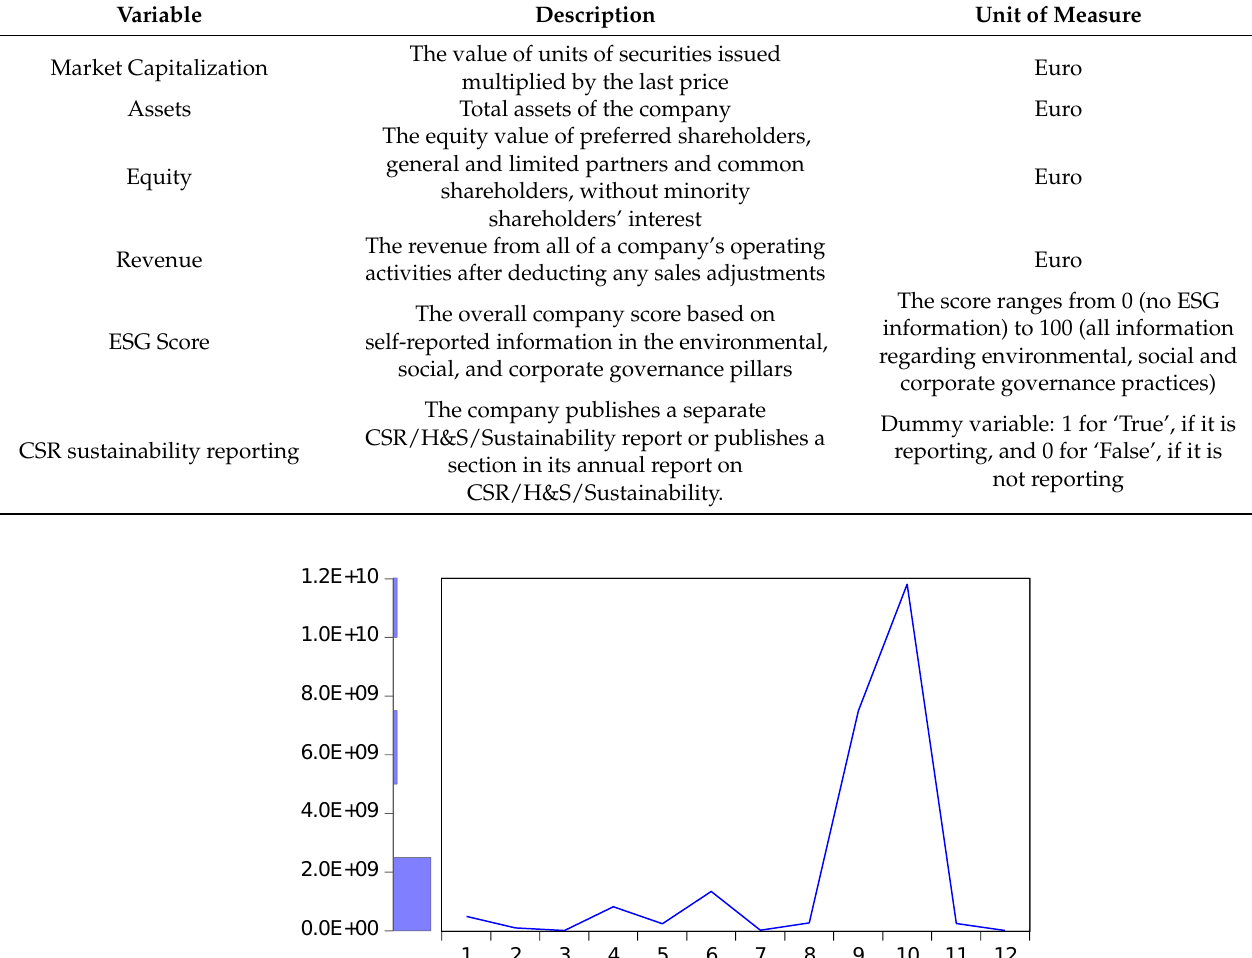
Table 1. Variables and data.